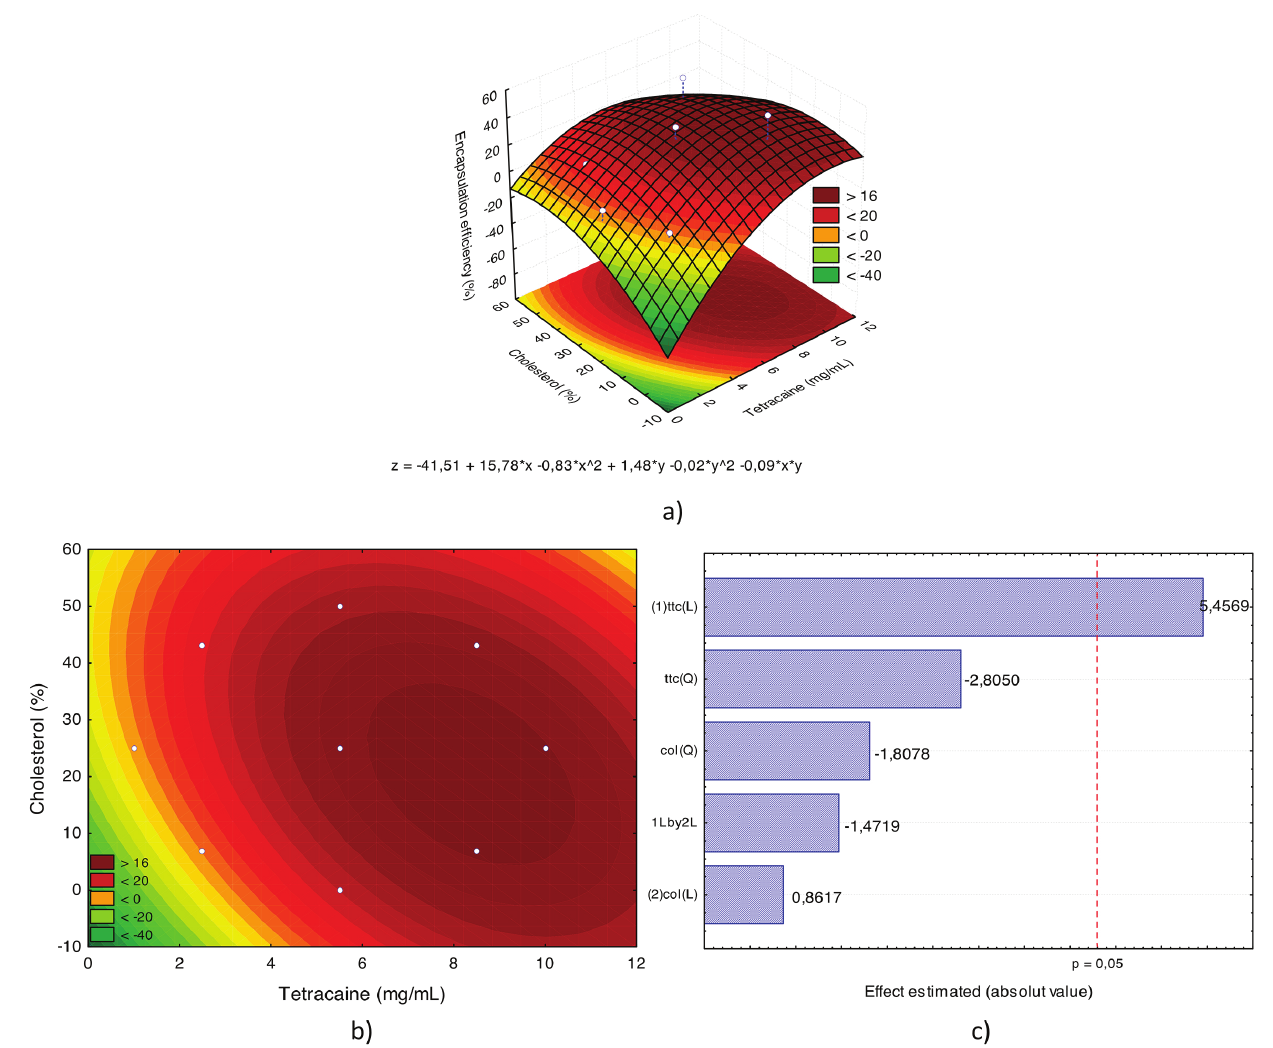
FIGURE 3 - Response surface (A), contour curve (B) and Pareto chart (C) for the encapsulation efficiency of liposomes prepared in the hydrophilic